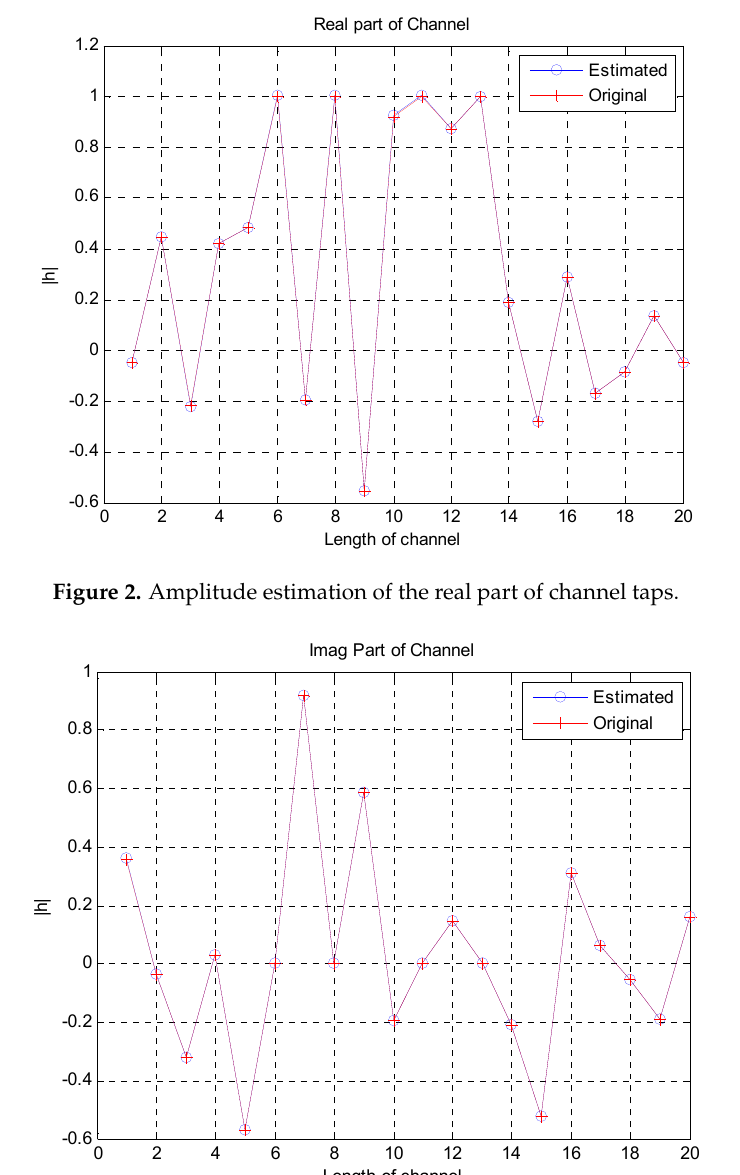
Figure 3. Amplitude estimation of the imaginary part of channel taps.